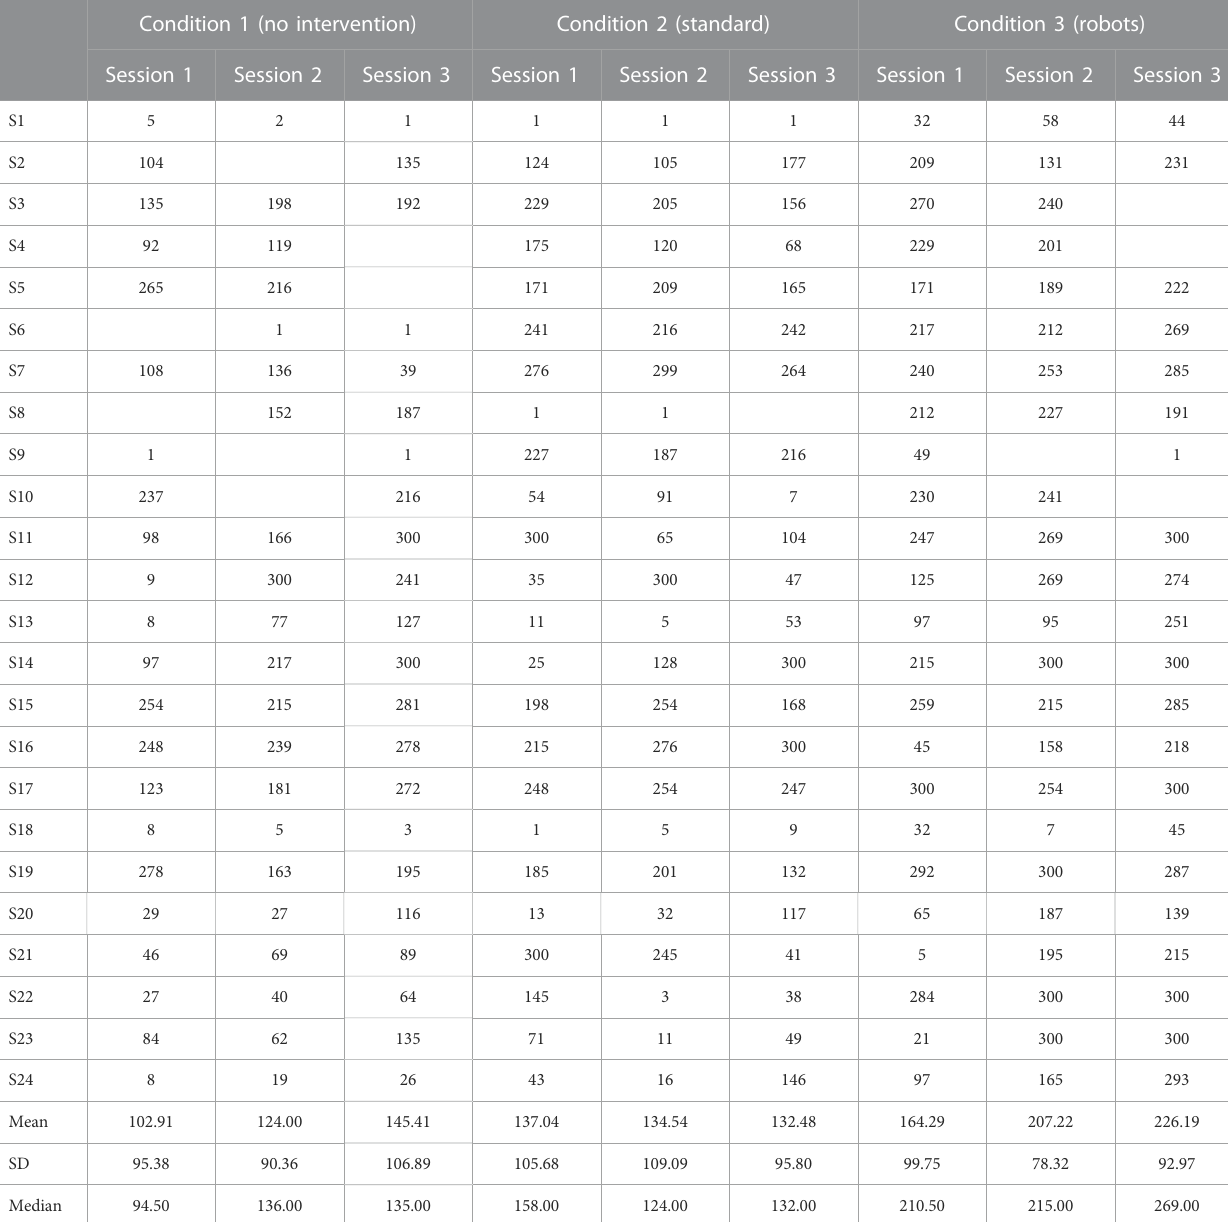
TABLE 2 Response latency (in s) for each participant by session and experimental